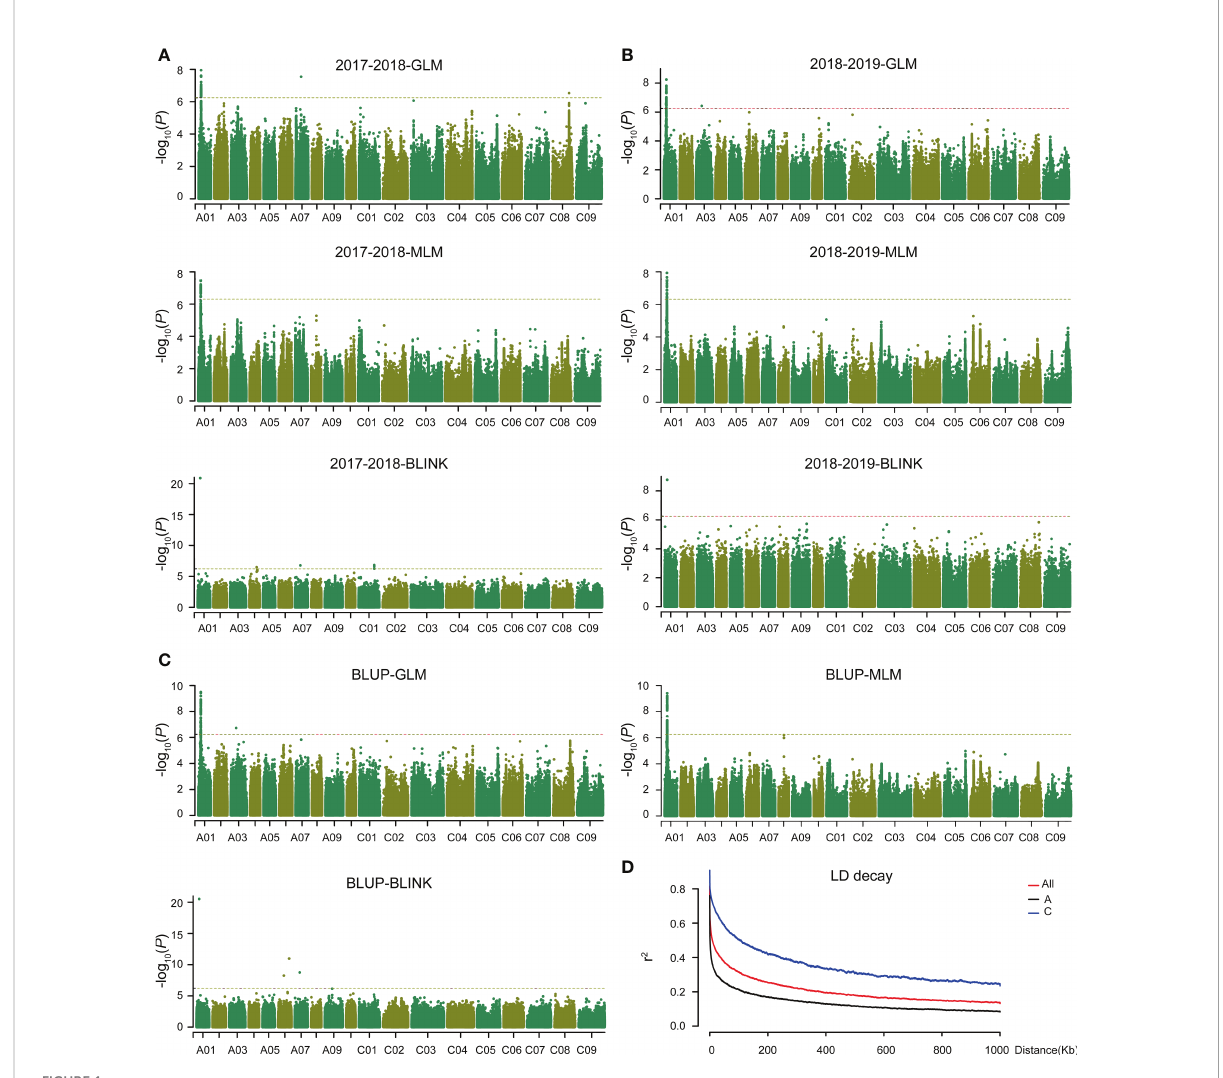
FIGURE 1 GWAS of plant height in Brassica napus and LD decay analysis. The threshold value is -log 10 (1/SNPs number). (A) GWAS of plant height in 2017 – 2018 based on GLM, MLM, and BILNK models. (B) GWAS of plant height in 2018 – 2019 based on GLM, MLM, and BILNK models. (C) GWAS of plant height for BLUP based on GLM, MLM, and BLINK models. (D) Linkage disequilibrium (LD) decay of A and C sub-genomes and whole